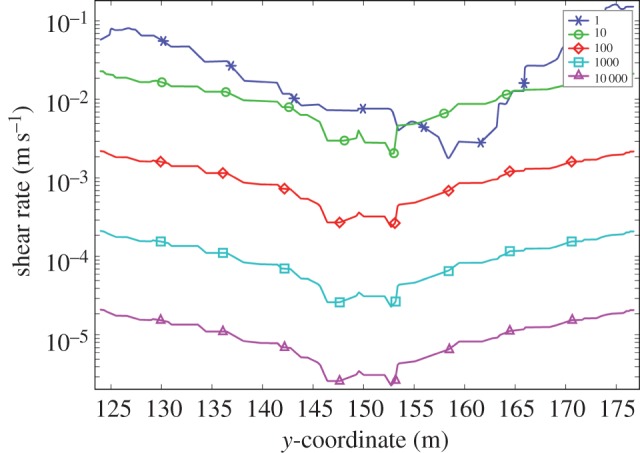
Variation in cross-sectional shear rate (γ˙ s−1) for a range of magma viscosities (Pa s) at position x = 120.